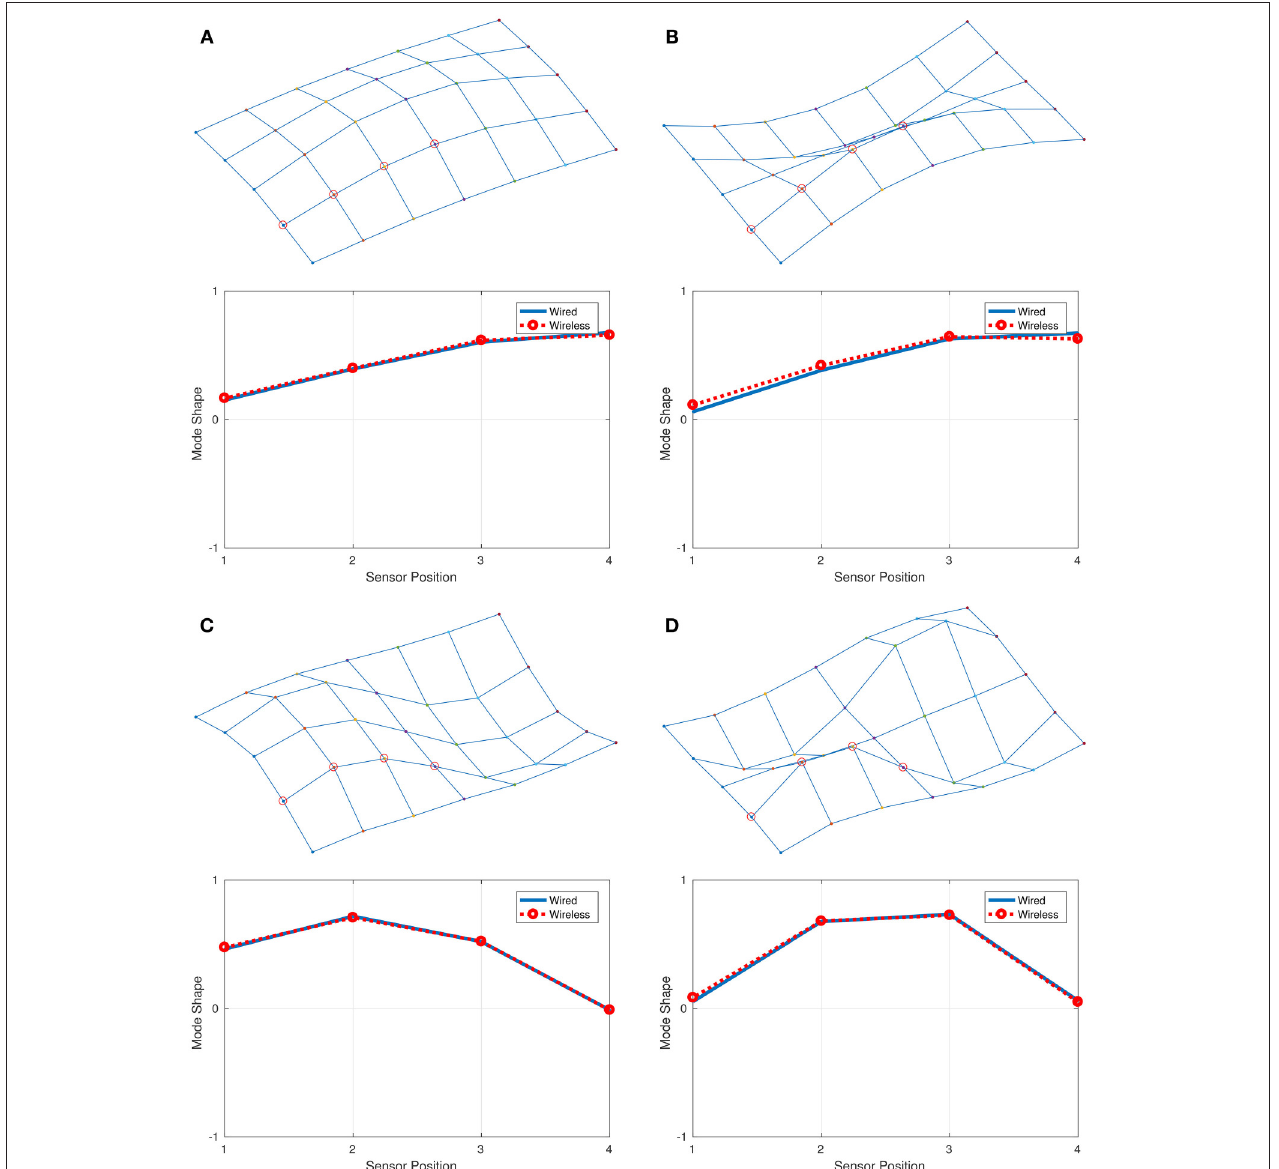
FIGURE 19 | Mode shapes from Wireless sensors and Wired sensors: (A) Mode B11, (B) Mode B12, (C) Mode B21, and (D) Mode B22.